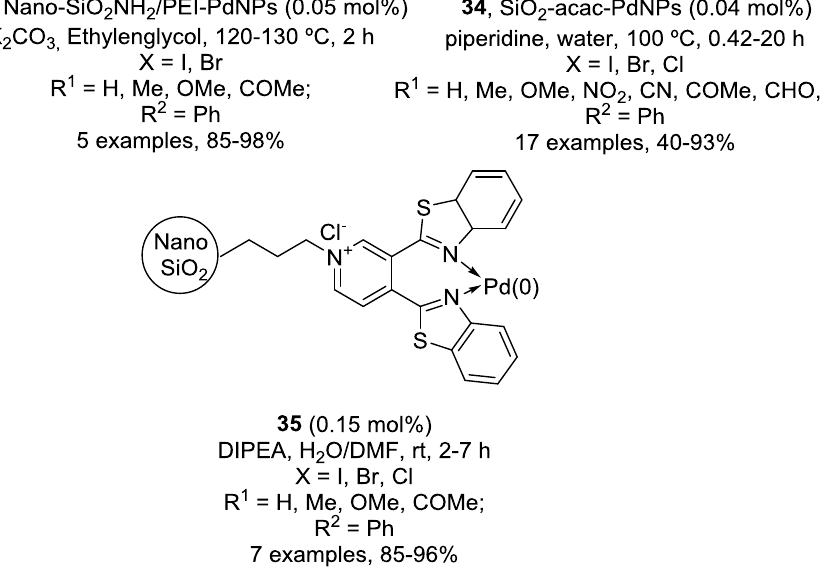
Figure 12. Silica-supported palladium catalysts for the Sonogashira reaction. Conditions, substrate scope and yield range (Scheme 2). scope and yield range (Scheme